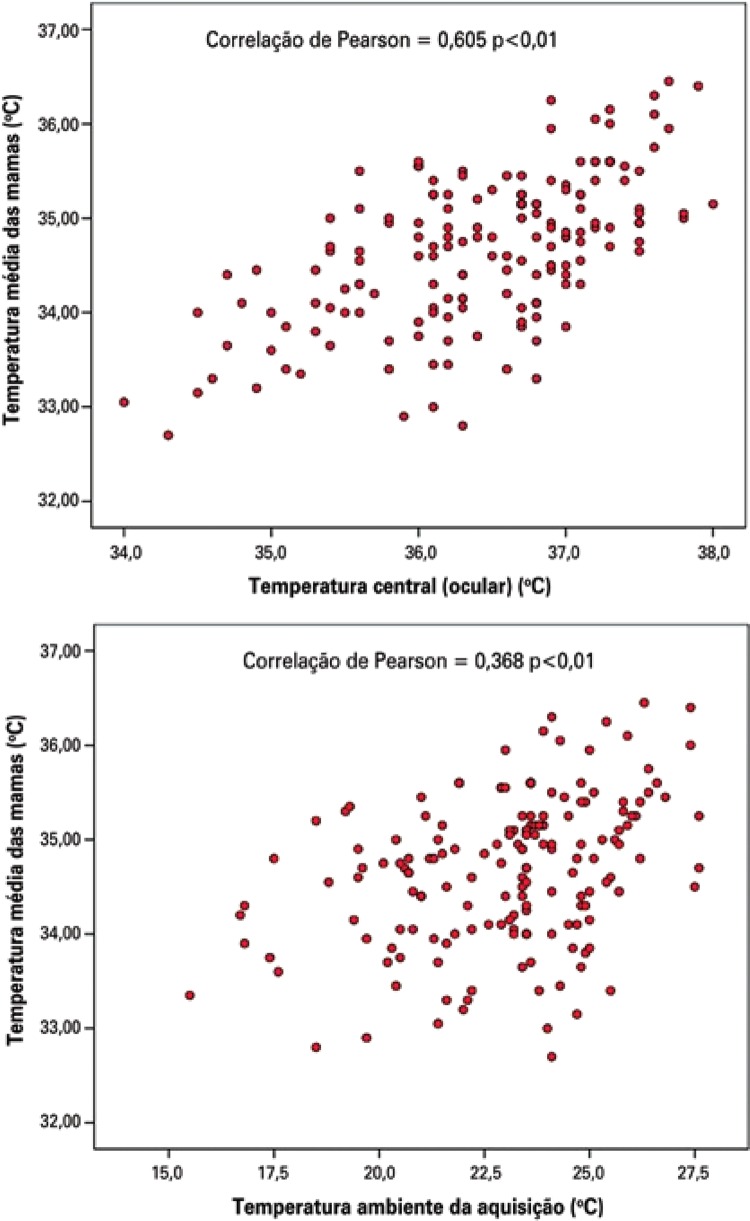
Correlação entre temperatura média das mamas com temperatura ocular máxima (TMO central) e temperatura ambiente no momento da aquisição